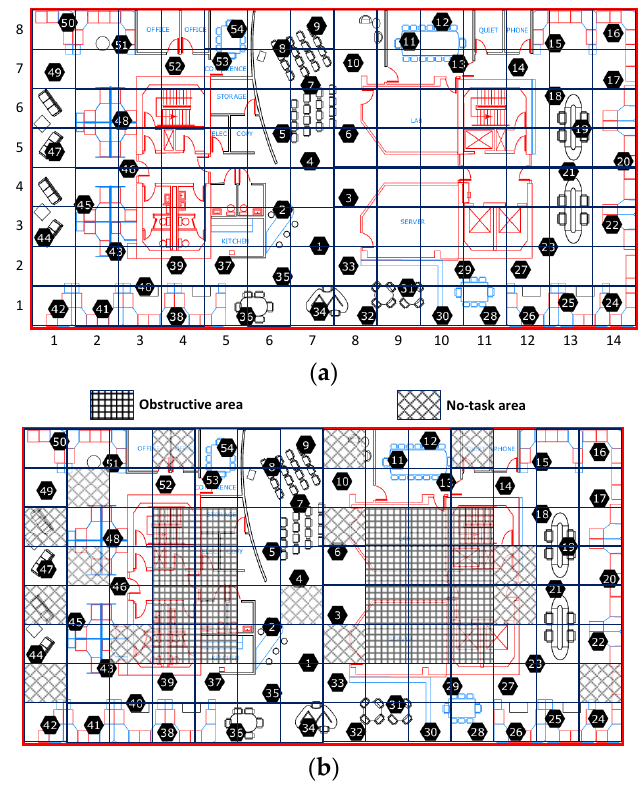
Figure 3. Simulation setup and environmental observations in Intel Berkeley Research lab. ( a ) Sensor deployment and grid-based task area; ( b ) Possible task areas and participant-moving areas.